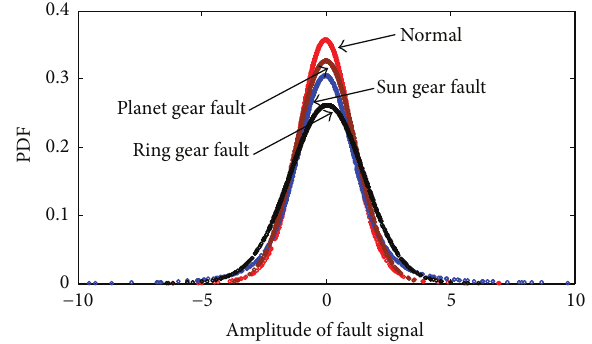
Figure 32: PDF of planetary gearbox fault vibration